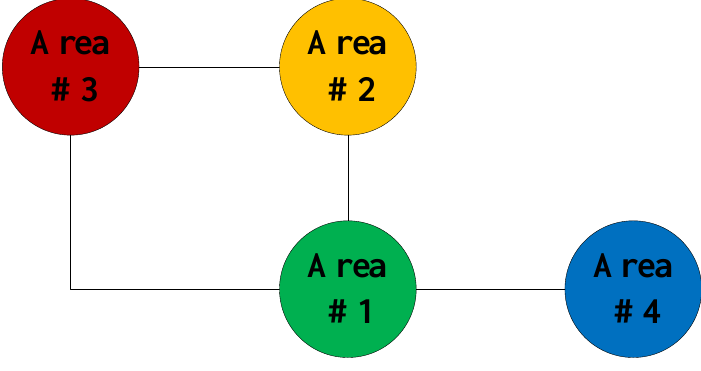
Figure 4. Four-area power system under investigation. Table 1. Parameters of the four-area power system with non-reheated